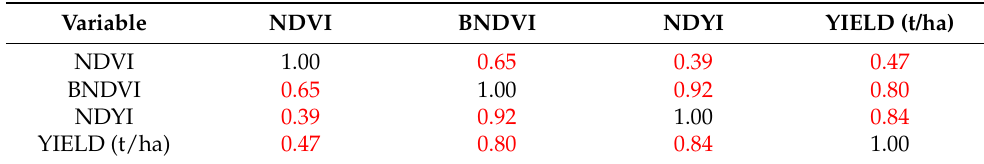
Table 4. Summary of correlations (Pearson’s correlation coefficient R) among the measured variables. Variable NDVI BNDVI NDYI YIELD (t/ha) NDVI 1.00 0.65 BNDVI YIELD